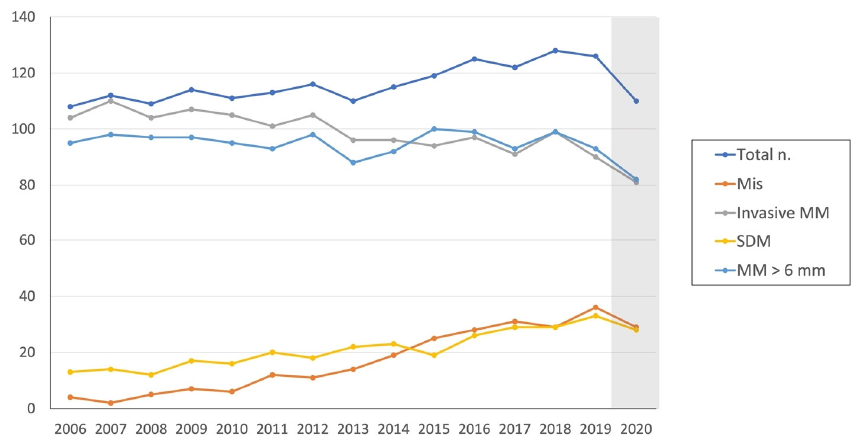
Figure 1. Trends in melanoma diagnoses from 1 January 2006 to 31 December 2020 at the Fondazione IRCCS Ca’ Granda Ospedale Maggiore Policlinico, Milan, Italy. The gray column in 2020 symbolizes the beginning of the era of COVID-19.